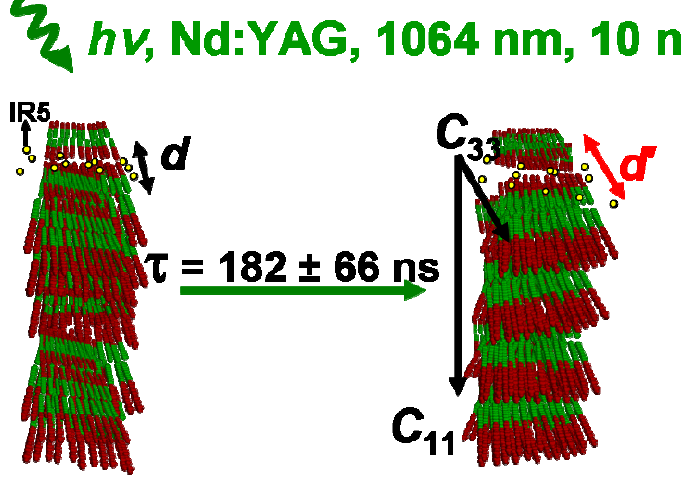
Figure 12. Schematic representation of the proposed mechanism. Upon optical excitation periodic organization occurs. However, the increased d -spacing diminishes the integral and C are the acoustical modes along the transversal and diffracted intensity. C 11 33 longitudinal directions and the yellow dots the laser dye